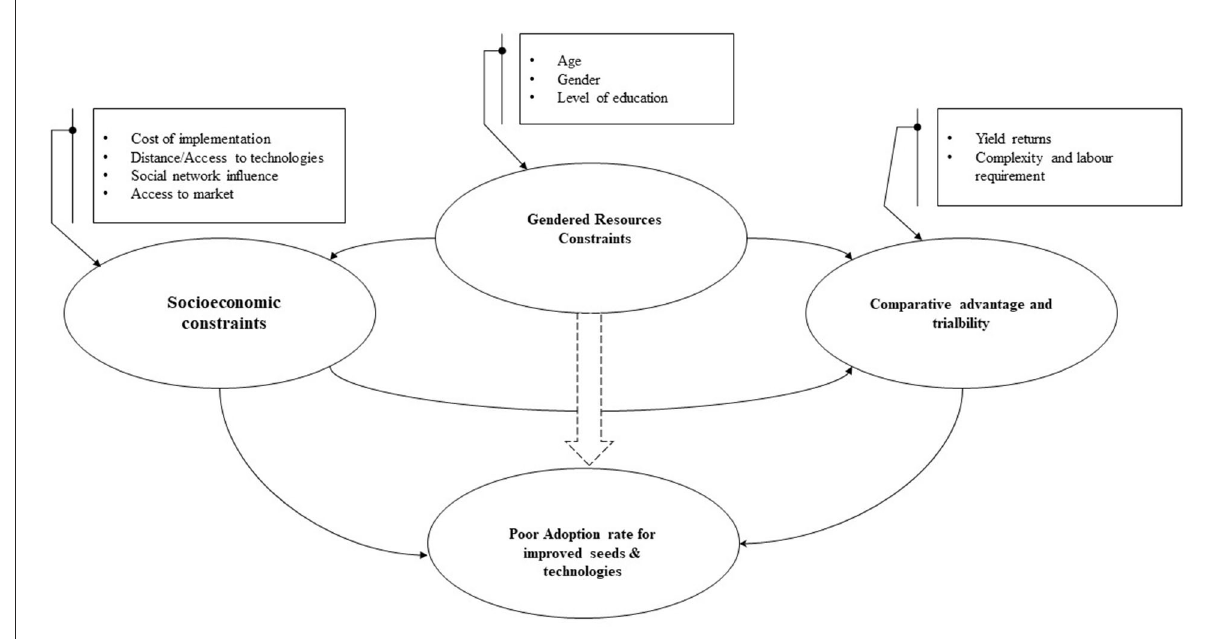
FIGURE1 Theoretical framework adopted for research. Authors,